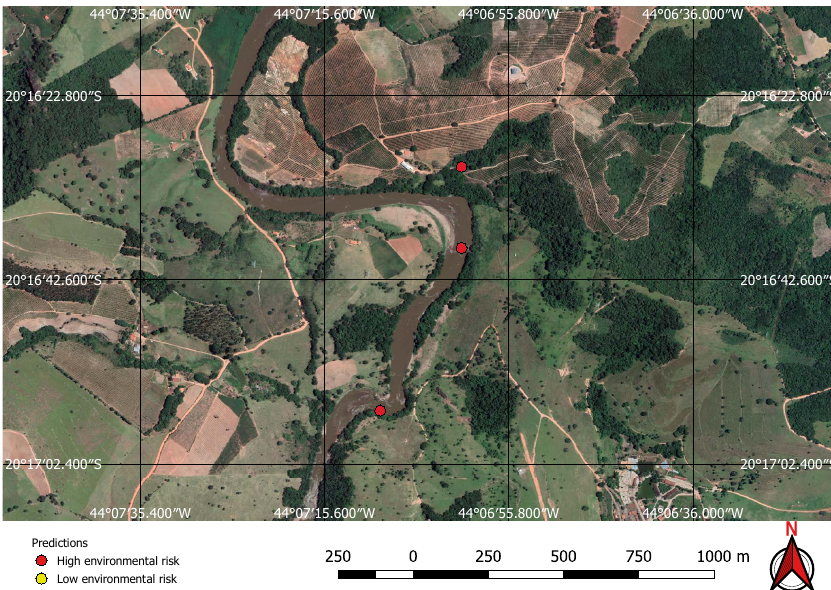
Figure 15. River bank incorrectly identified as a mine by the neural